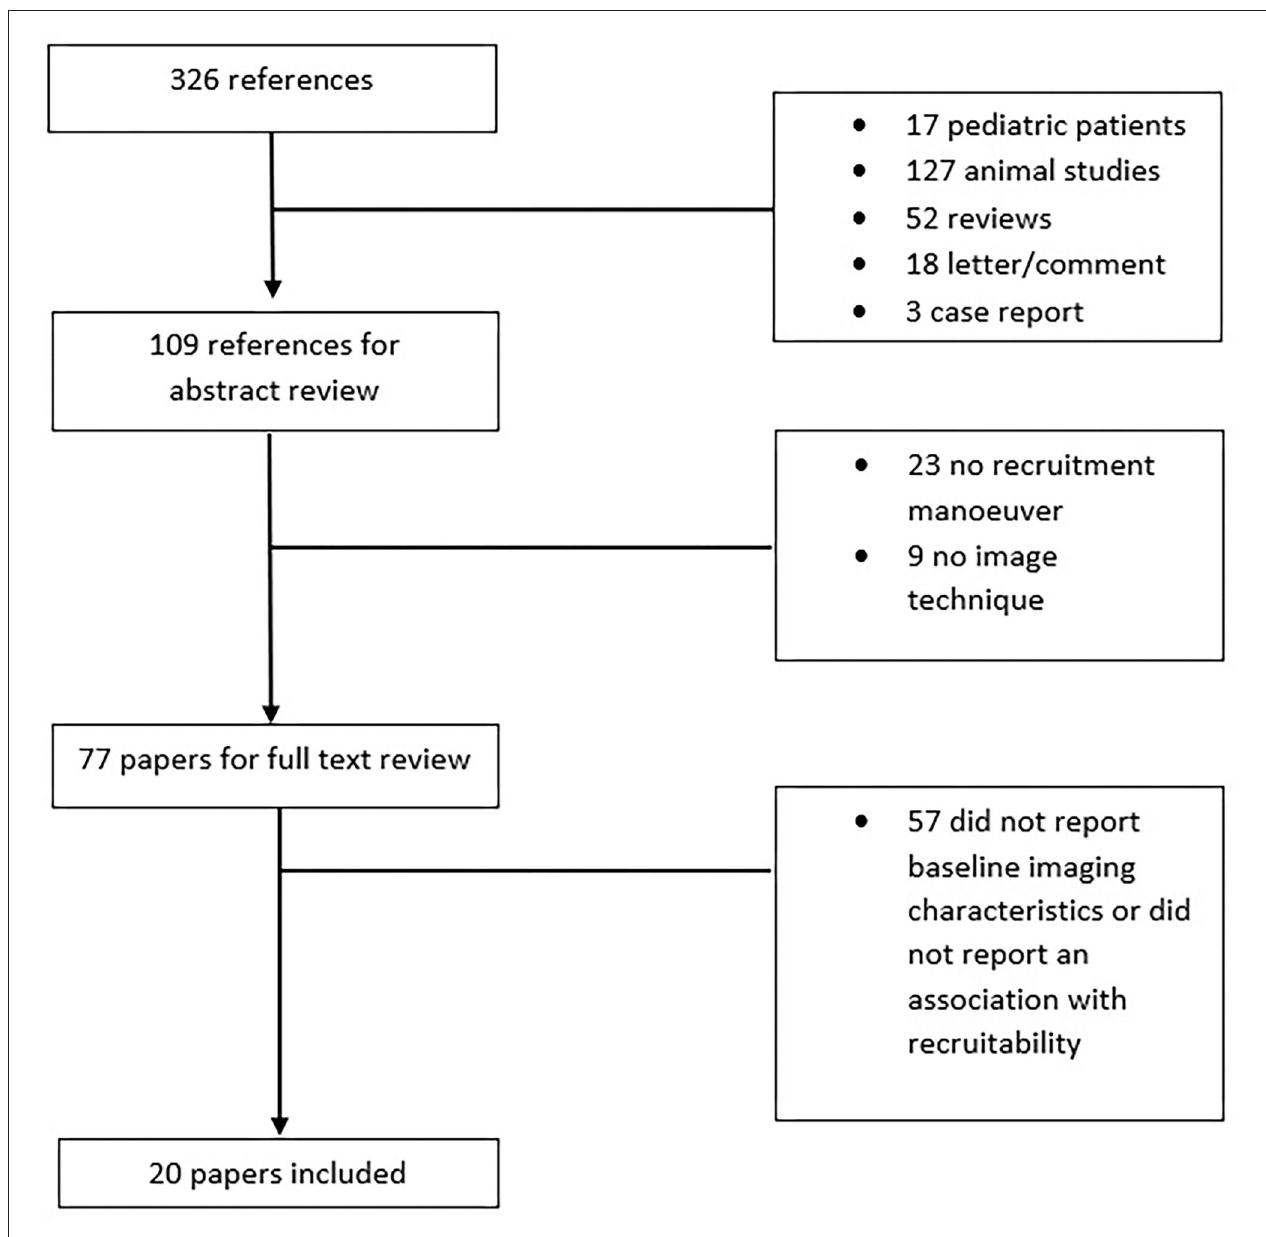
FIGURE 1 | Flow diagram of the study